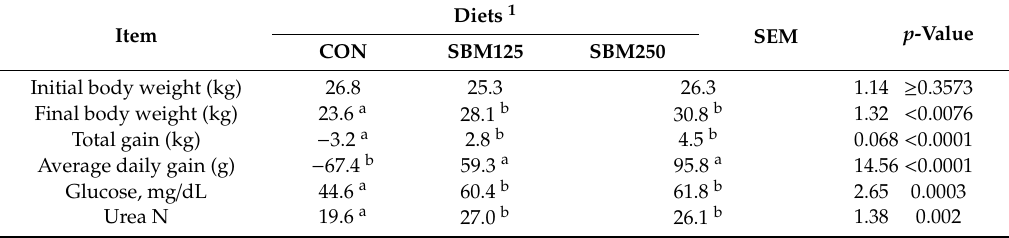
Table 3. E ff ect of protein supplementation on growth performance and blood metabolites of Awassi lambs fed low-quality forages.